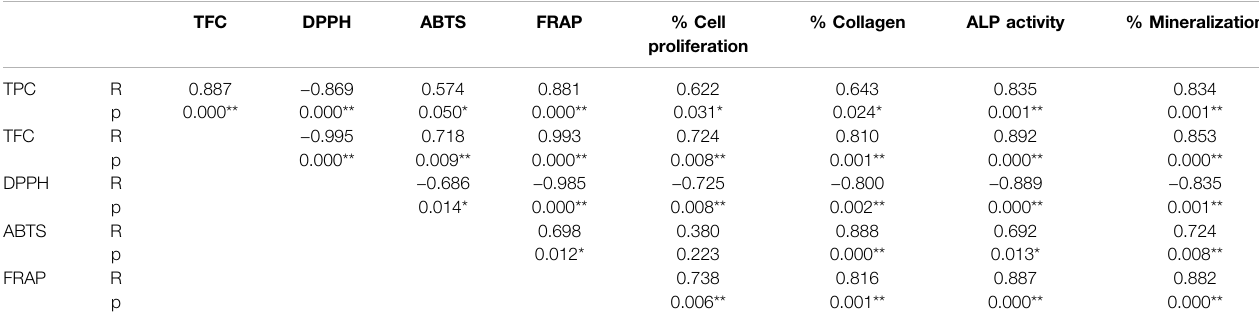
TABLE 4 | Pearson correlation between TPC, TFC, antioxidant and anabolic